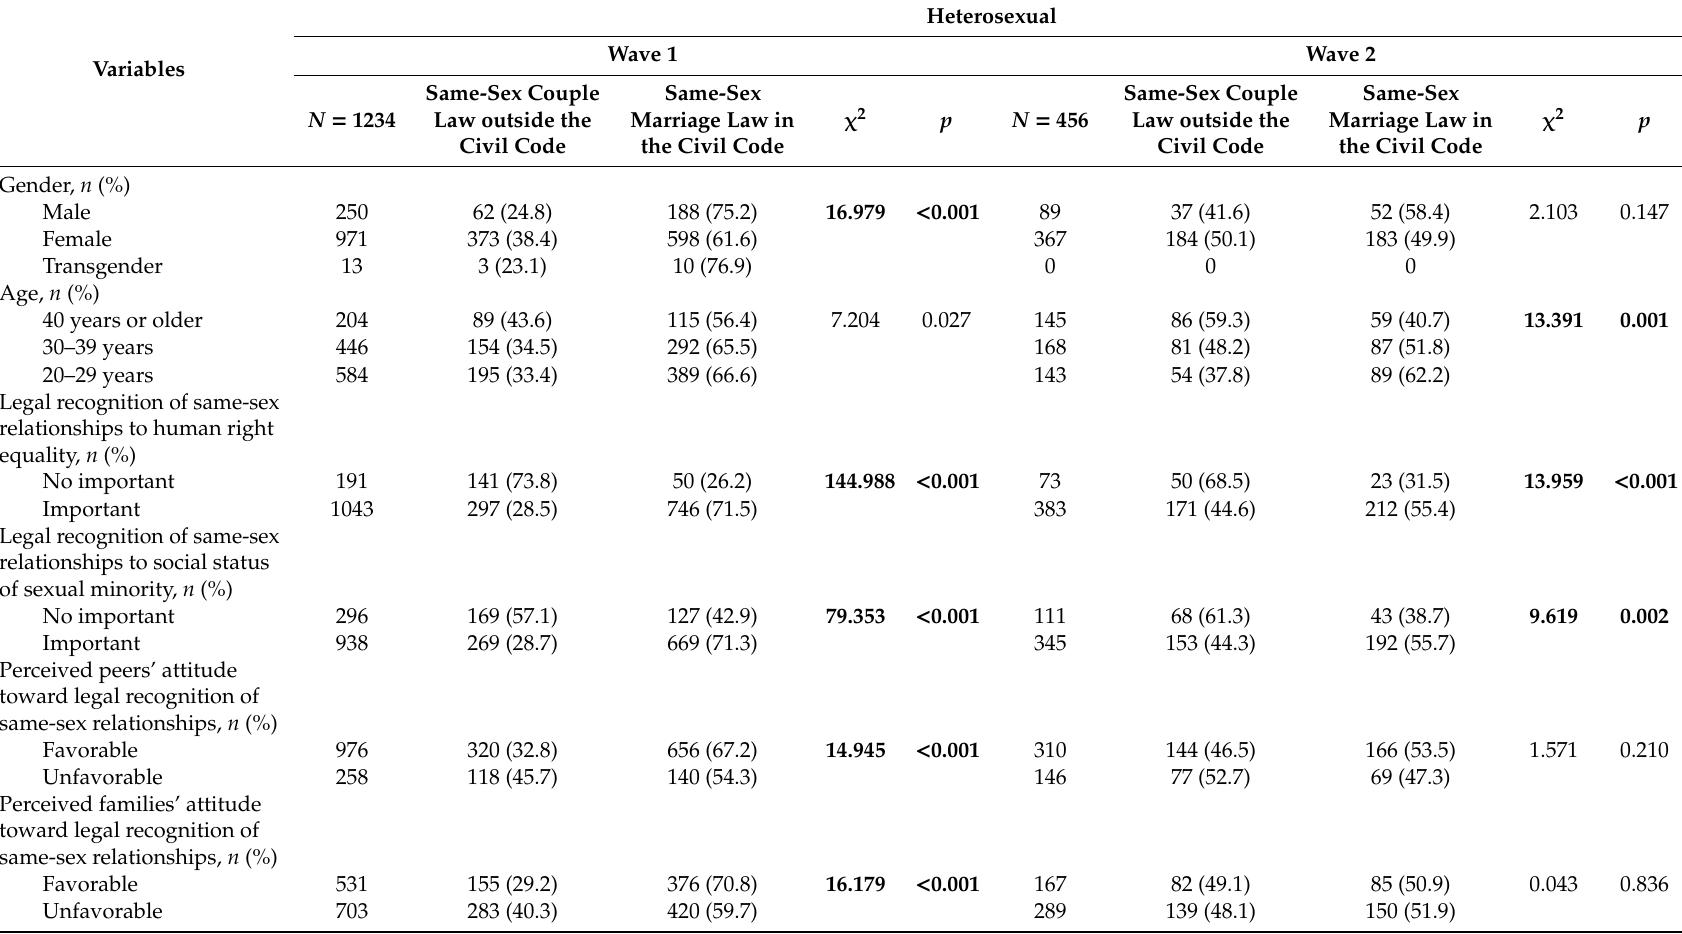
Table 3. Comparisons of gender, age, personal belief, and perceived social attitudes between heterosexual participants supporting the legalization of same-sex relationships with various preference of forms of laws in Wave 1 and Wave